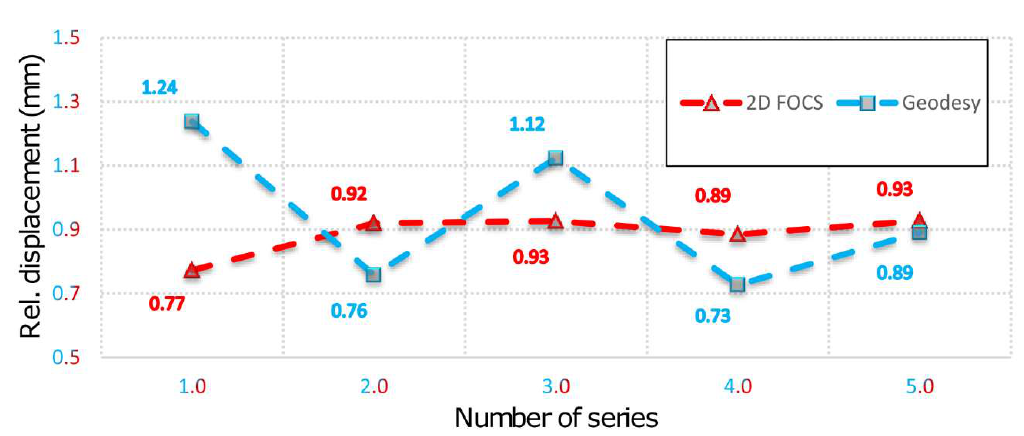
Figure 6. Values of relative displacements registered by 2D deflection sensor and geodetic measurements.